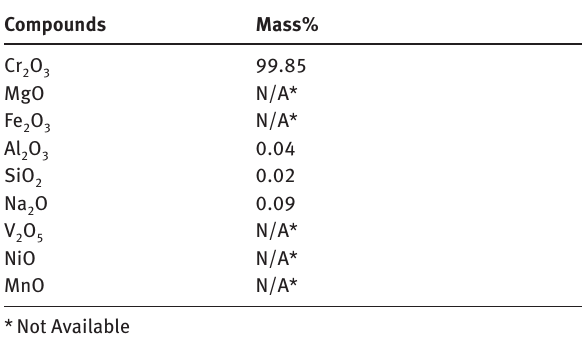
Table 2: Chemical analysis of obtained chromium oxide Compounds